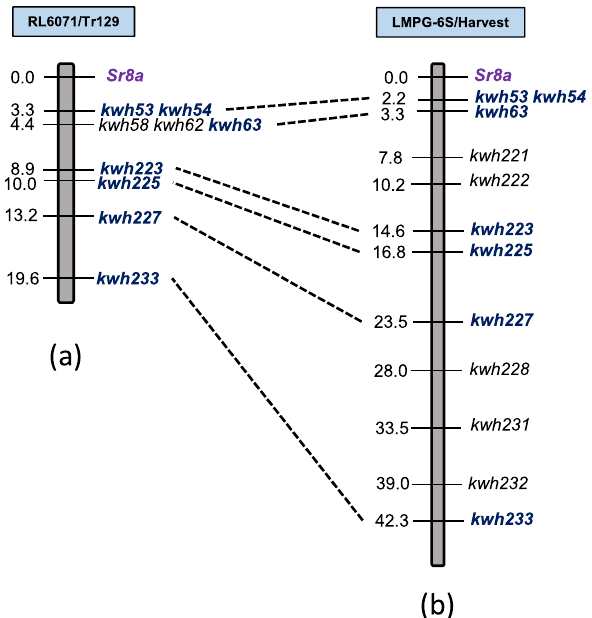
Figure 2. Comparison of Sr8a linkage maps from RL6071/Tr129 DH population from the present study ( a ) and the LMPG-6S/Harvest DH population from Hiebert et al. 16 ( b ). Common markers between two linkage maps are in dark blue font , and purple font was used for the postulated gene. Distances between loci are in centimorgans